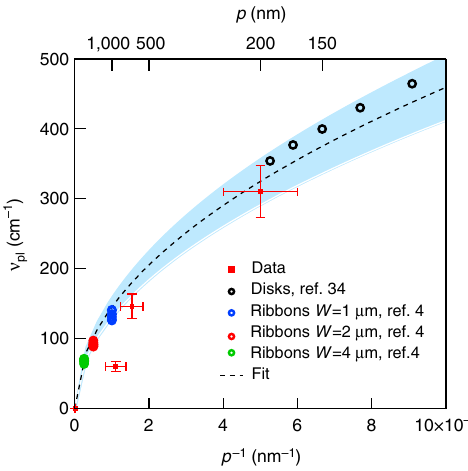
Figure 4 | Optical properties of NPG at fixed Fermi energy for different pore size. ( a , b ) SEM images of nanoporous graphene samples with the same average Fermi energy E F B 70meV, and decreasing pore size. Scale bar corresponds to 1 m m. ( d – f ) corresponding optical conductivity curves (pore size decreases from a – c ). The whole fitting (see equation (1) in the text), and the plasmon and interband components are represented by blue- dashed, blue dotted and green dotted lines, respectively. NPG, nanoporous graphene; SEM, scanning electron microscope.